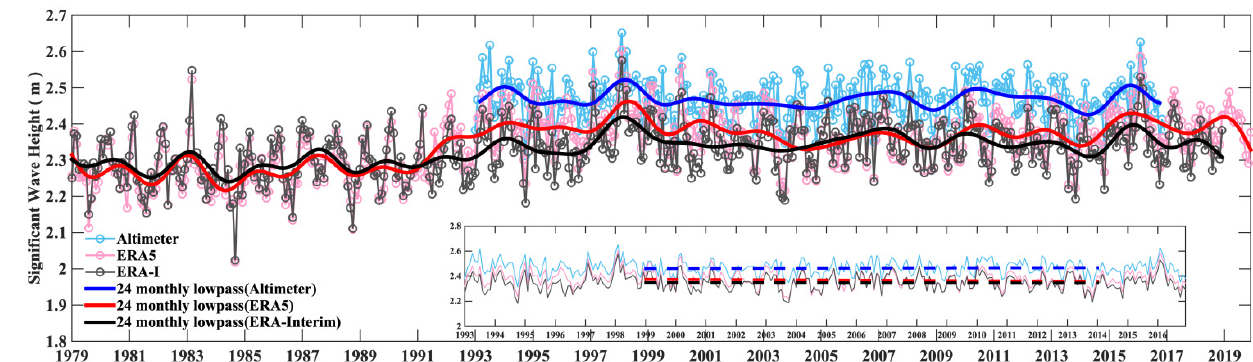
Figure 4. Time series of monthly-averaged SWH measured by altimeter, ERA5 and ERA-Interim (the solid lines are 24-month low-pass-filtered values). The root-mean-square error of monthly averages between ERA5 and altimeter was 0.09 m. The rms error of monthly averages between the ERA-I and the altimeter was 0.12 m. The small insert in the lower right corner shows the monthly average time series from 1993 to 2016. The three dotted lines represent the linear fittings of SWH measured by altimeter, ERA5 and ERA-Interim from 1999 to 2013, respectively. The SWH slope from the altimeter was 0.04 cm/month; the SWH slope from ERA5 was − 0.1 cm/month; and the SWH slope from ERA-Interim was − 0.02 cm/month.